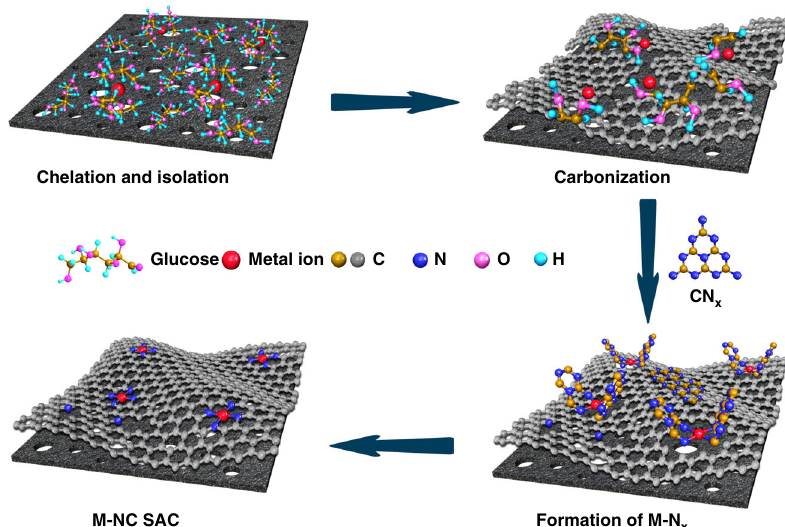
Fig. 1 The cascade anchoring strategy for the synthesis of M – NC SACs. First, chelating agent (glucose) ef fi ciently sequesters metal ions and binds to O-rich carbon support, while excessive glucoses physically isolate glucose – metal complexes on carbon substrate. Second, the chelated metal complexes further secure metal atoms via the decomposed residues up to certain temperature. Third, CN x species decomposed from melamine at higher temperature subsequently capture metal atoms to form M – N x moieties and integrate into the pyrolyzed carbon